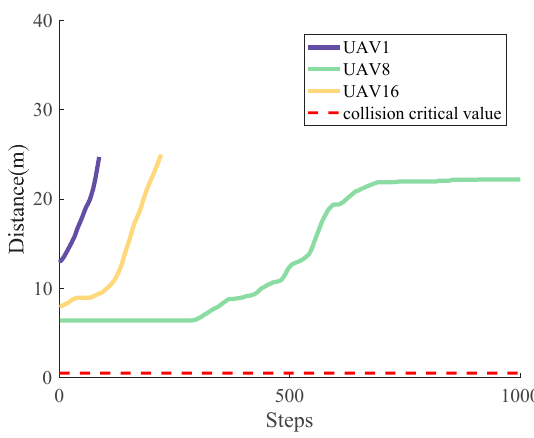
Figure 16. The variation of distance between UAVs and obstacles.